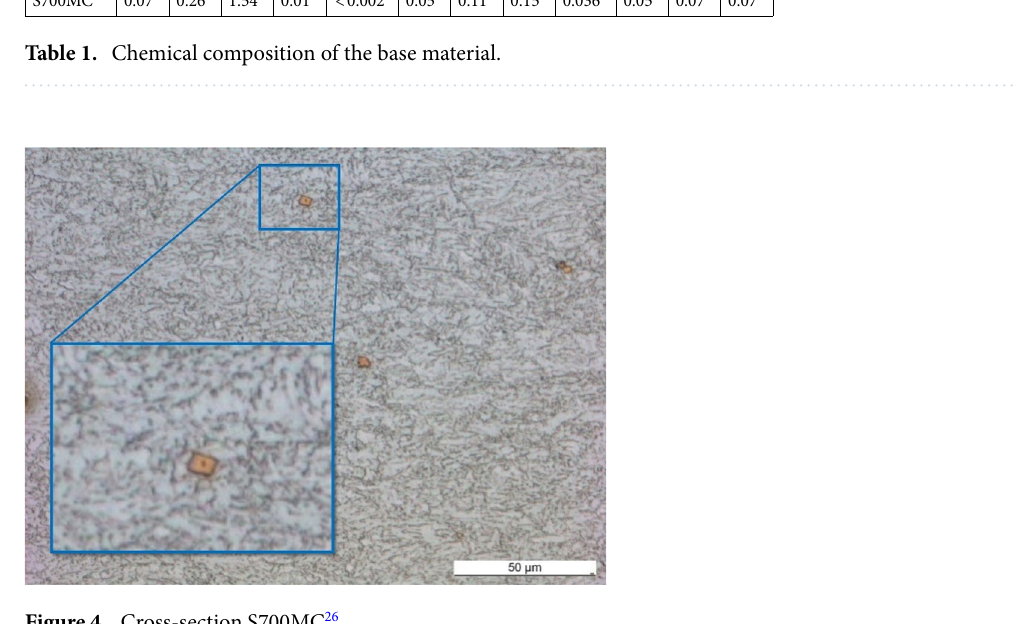
Figure 4. Cross-section S700MC 26